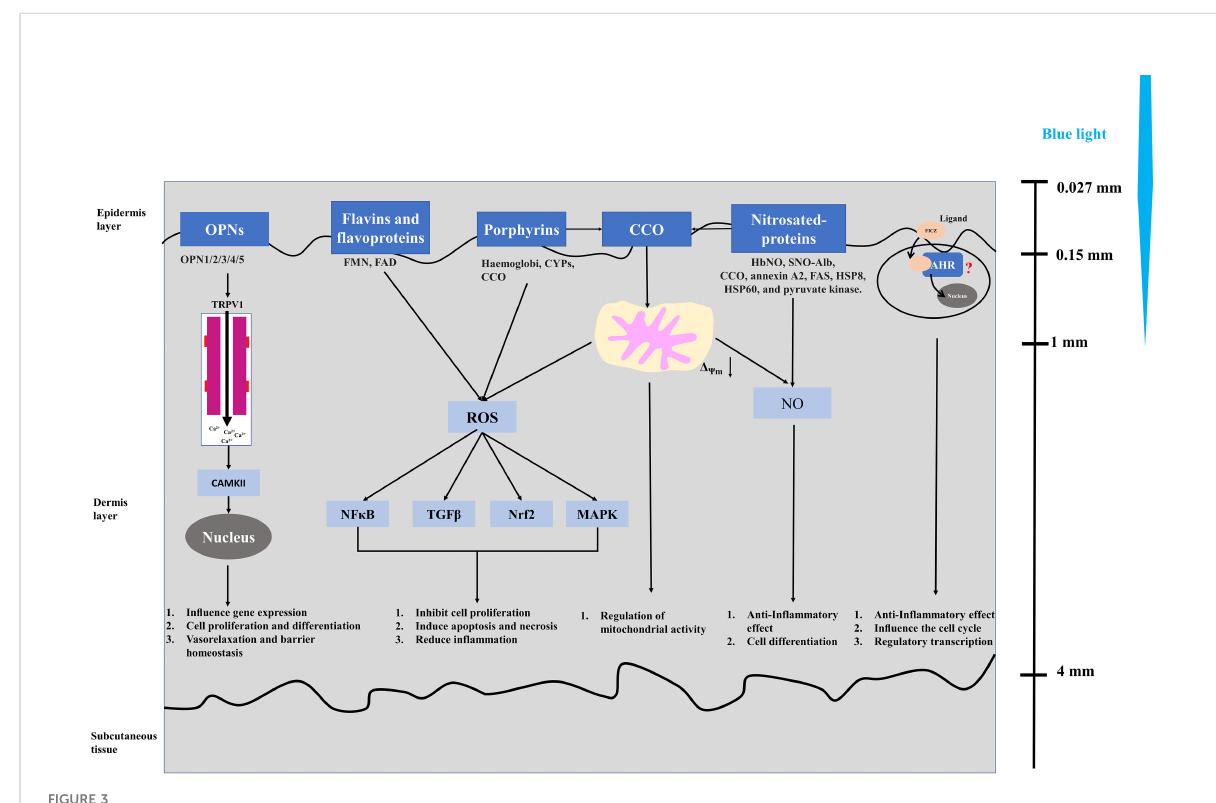
FIGURE 3 Mechanism of blue light affecting non-pigmented mammalian